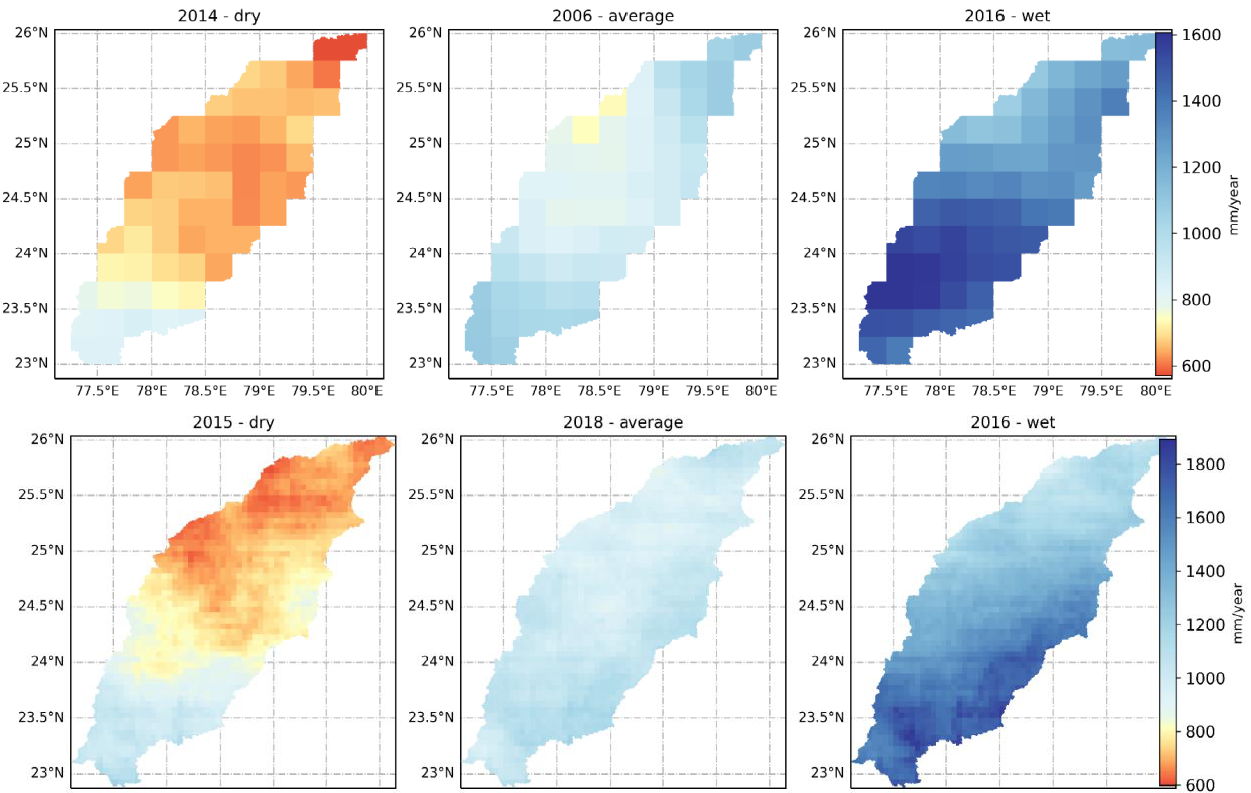
Figure 2. Figure depicting PERSIANN and CHIRPS precipitation datasets, based on the spatial distribution of mean monthly precipitation in the BRB.